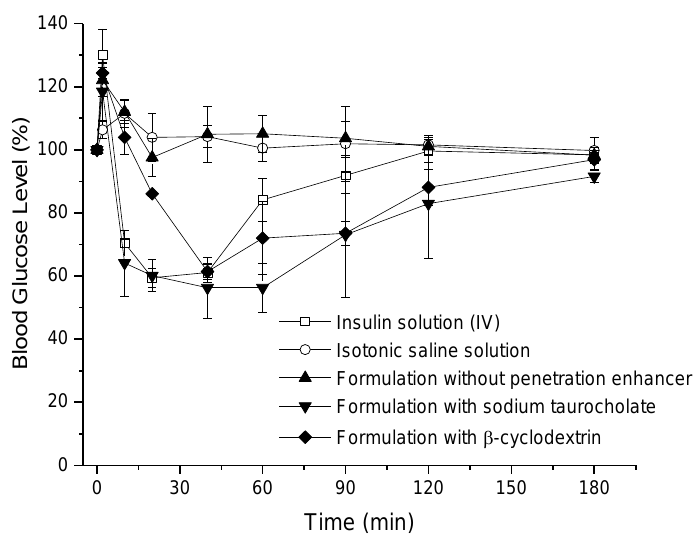
Table 3. Percentage of the theoretical insulin content determined by RP-HPLC and SEC.